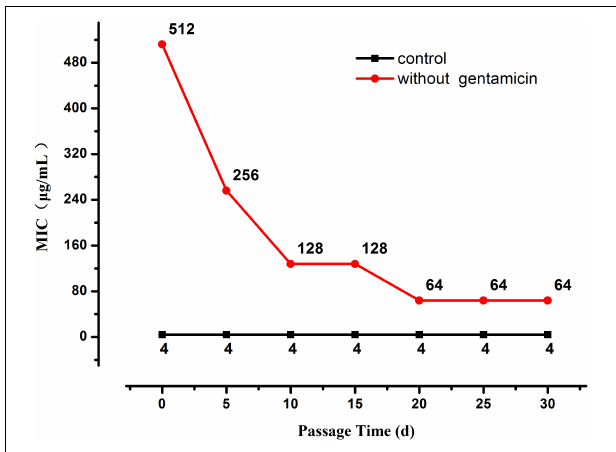
FIGURE 2 | Changes in MIC of resistant L. plantarum ATCC14917 in LSM without gentamicin, i.e., when selection pressure from gentamicin is removed.